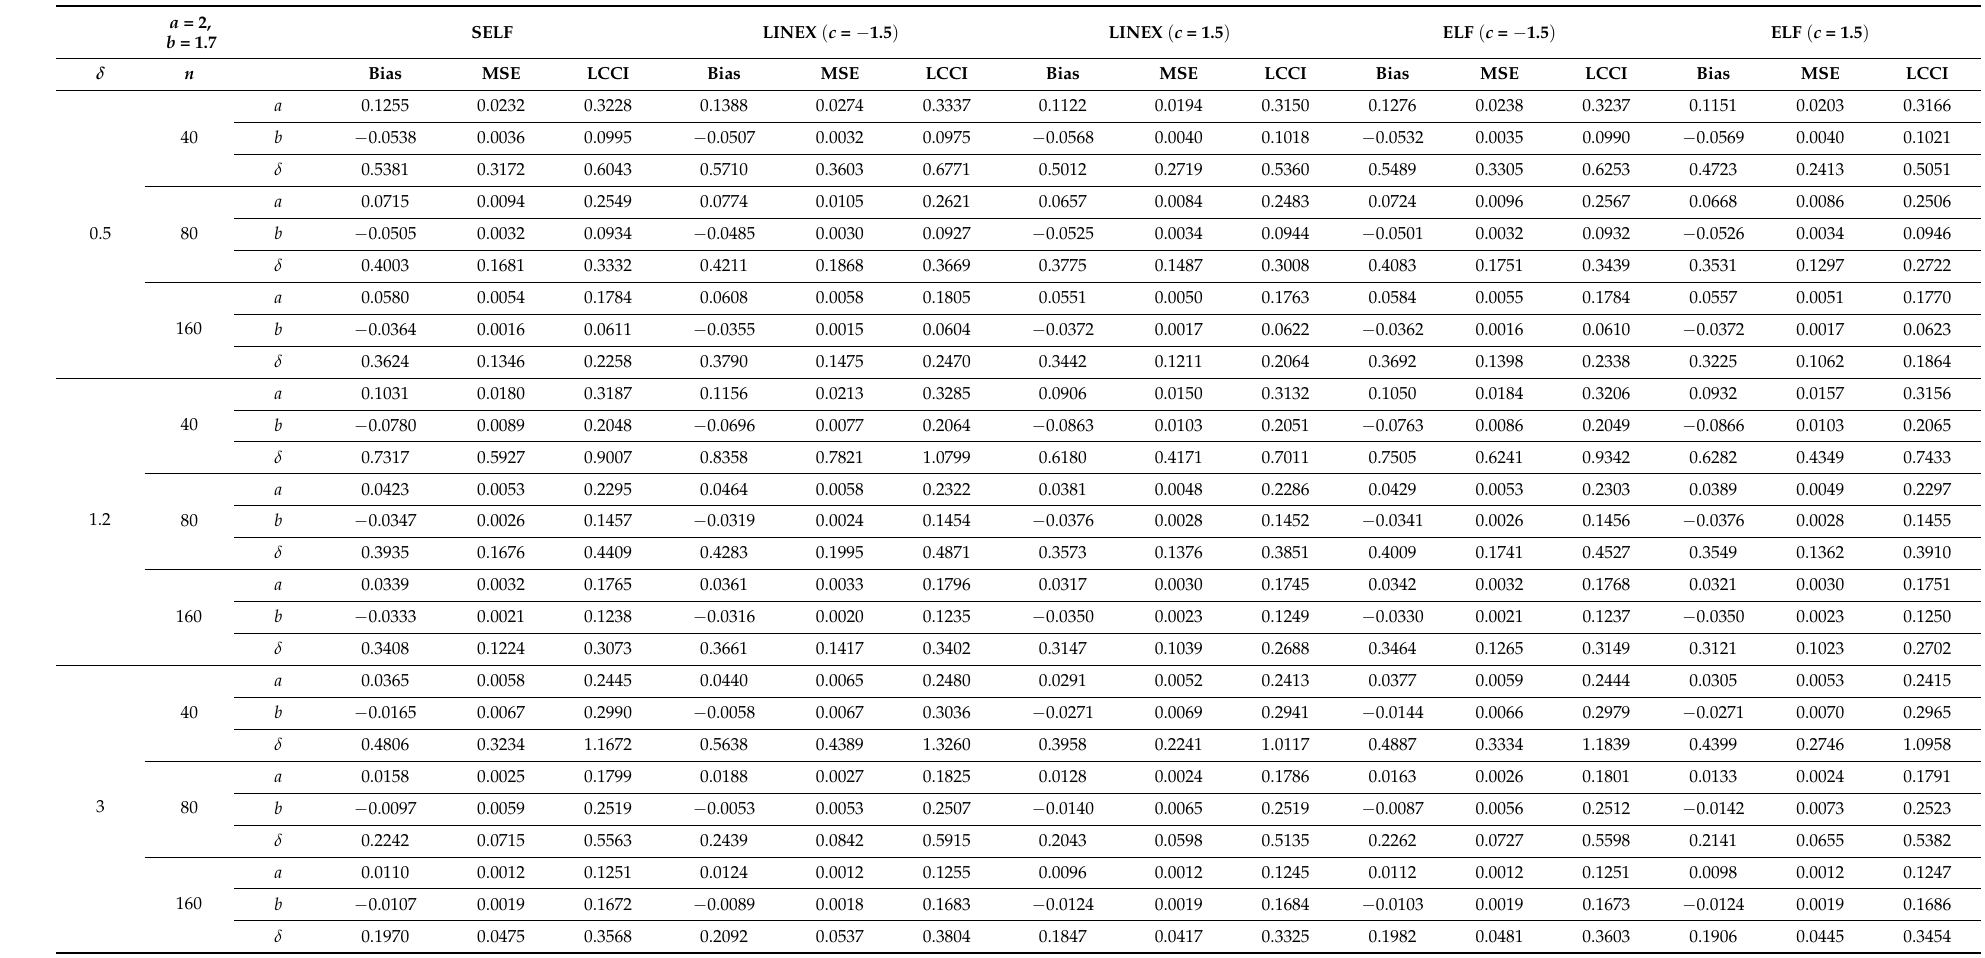
Table 6. Bayesian inference with different loss functions when a = 2, b =